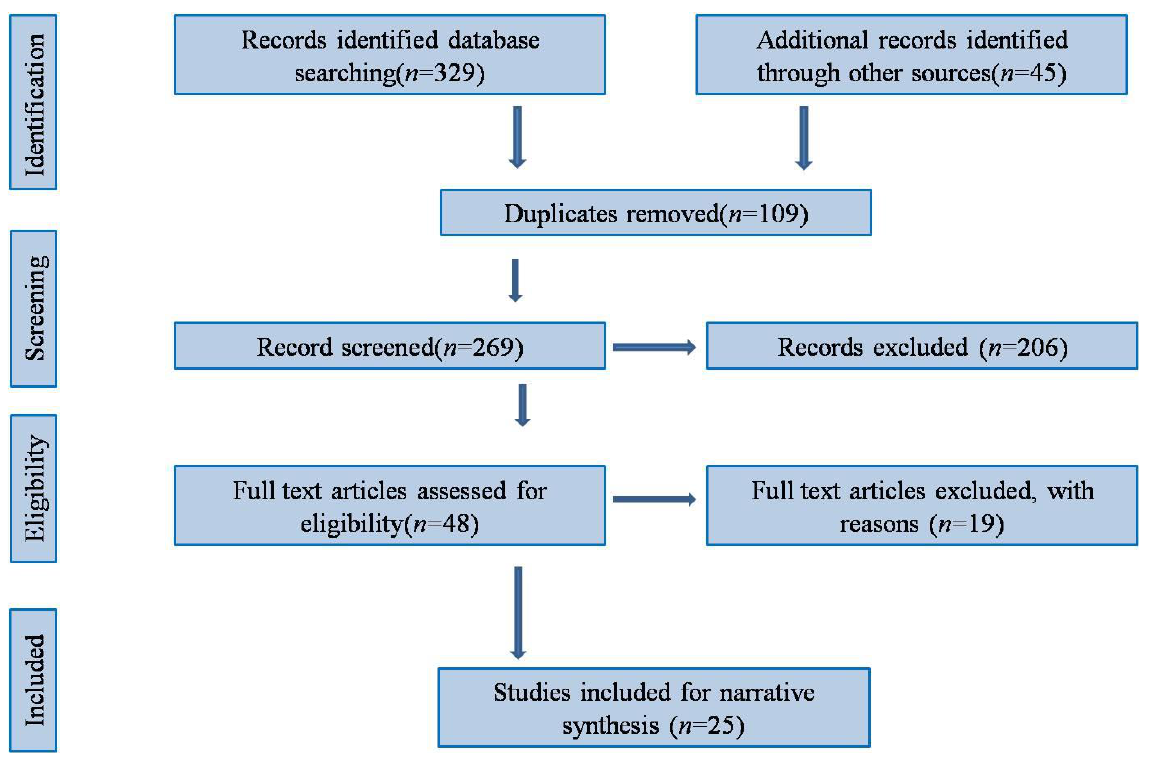
Figure 1. PRISMA flow diagram of the study selection process. This review covered publications from seven countries, all of which were from LMICs. Among the 25 articles included, 16 were from Sri Lanka, followed by two from India, Mexico, and El Salvador, and one from China and Malawi. All studies were conducted between the years 2000 and 2021. Of the total, 12 were case–control studies, followed by ten cross-sectional design studies and three cohort study designs. The included studies represent 38,351 participants, with the sample size ranging from 46 to 24,726. The details about the included studies are provided in Tables 1–4. A total of 17 studies were identified as mentioning their male and female status. In this, a total of 1933 males and 1368 females were reported. Seven studies were hospital based, whereas 22 were community-based. Table 1. Authors and study information.